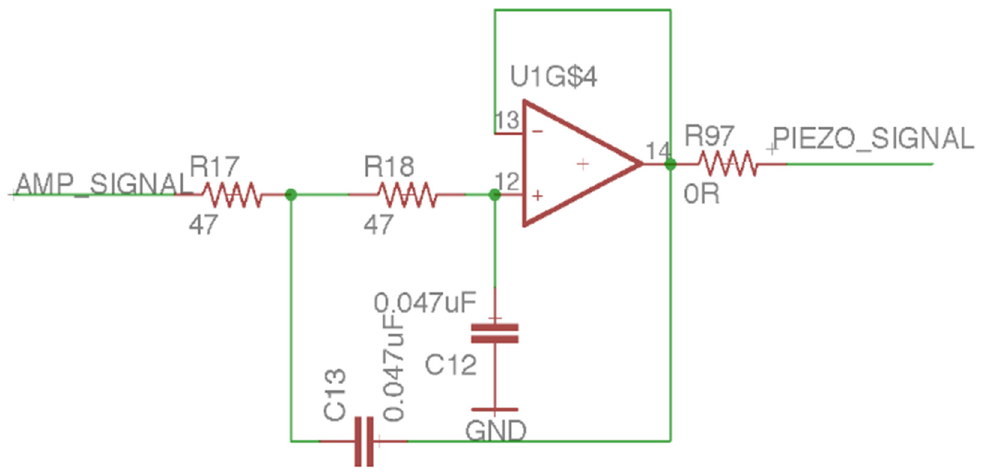
Figure 13. The low-pass filter with a Sallen–Key type of laser audio signal receiver circuit.